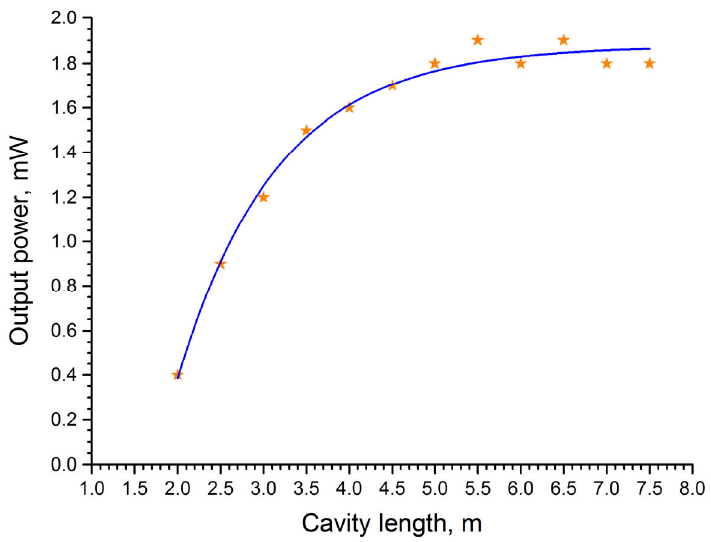
Figure 4. Dependences of the laser output power, measured at a constant pump power (40 mW), on the cavity length. Stars: experimental points, associated with a laser cavity of different lengths.